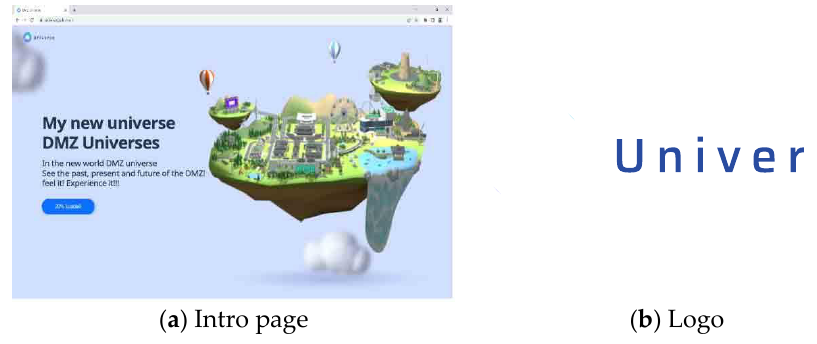
Figure 8. DMZ Universe (www.universe.go.kr accessed on 5 August 2022).